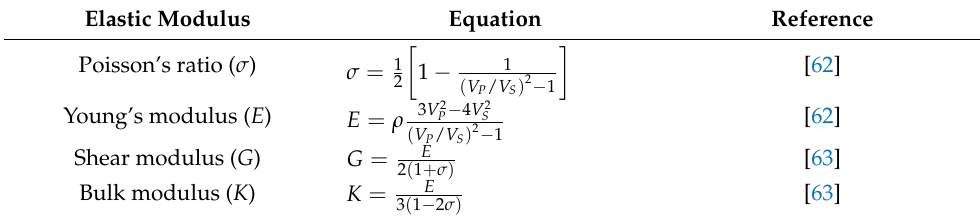
Table 3. Elastic moduli equations.